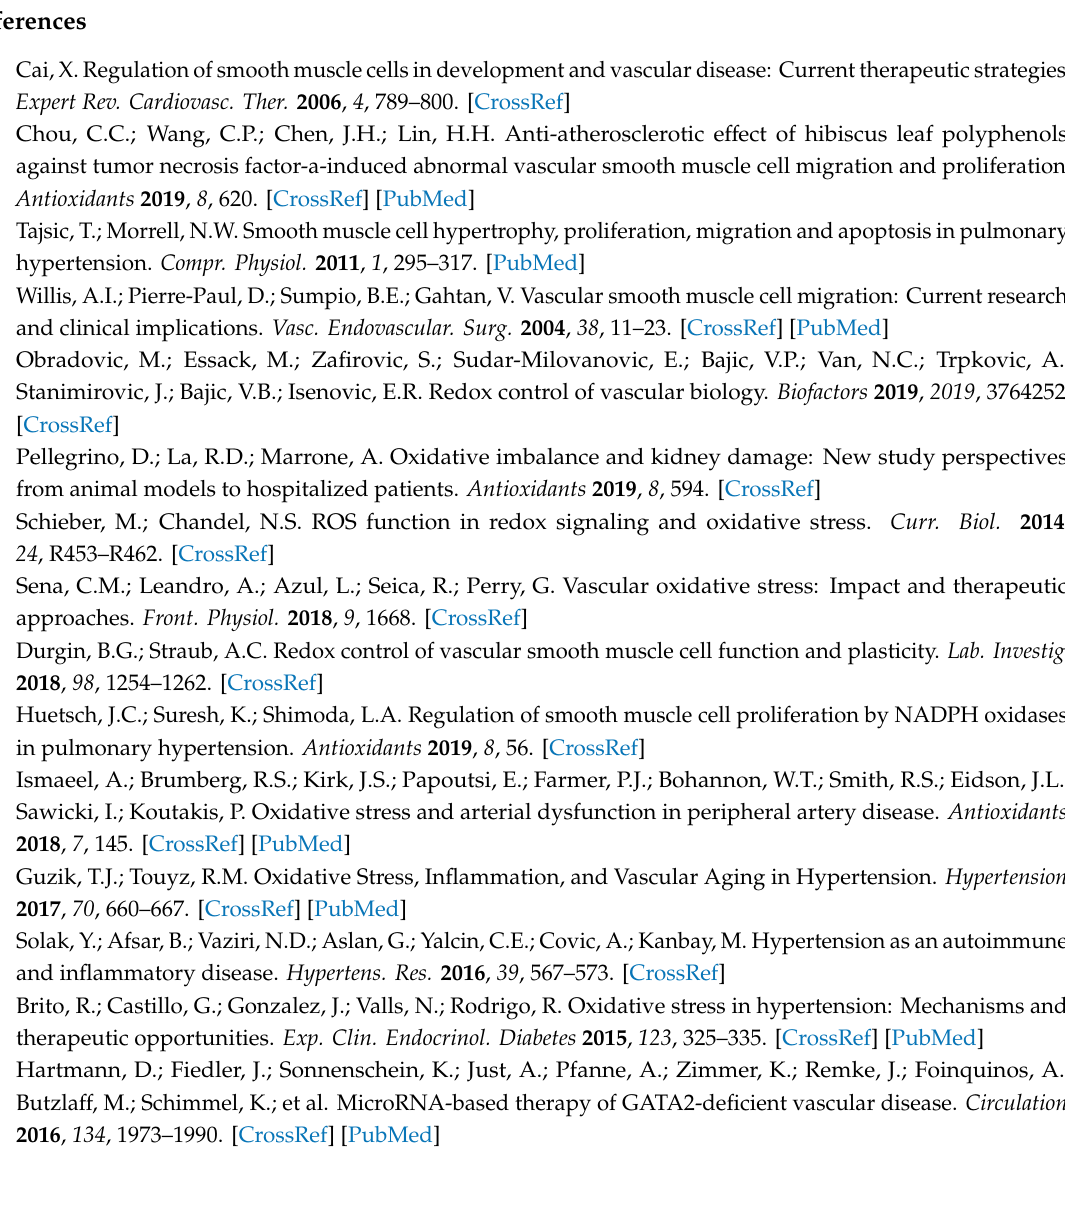
Table S1: Primers for real-time quantitative PCR analysis in